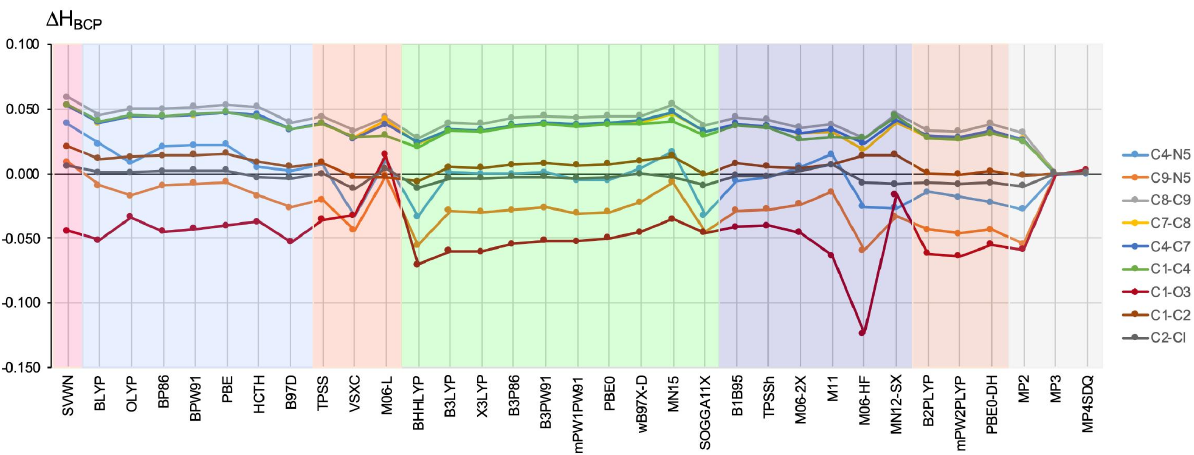
Figure 4. The difference (in relation to the CCSD method) in the value (in a.u.) of the total elec- tronic energy density determined at the bond critical point of the bond shown on the right side of the figure. The different types of methods are represented by a colored background: LDA—pink, GGA—blue, M-GGA—orangeish, H-GGA—green, HM-GGA—violet, DH-GGA—beige, perturbational